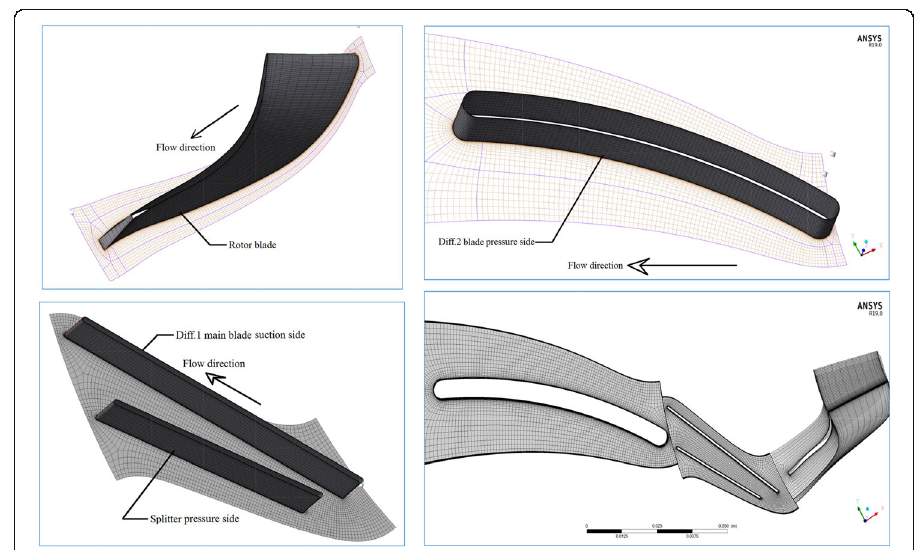
Fig. 3 Grid structure of the computational domain for the rotor and diffusers